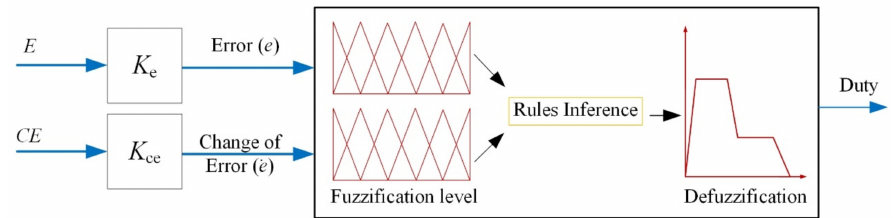
Figure 11. Normalized FLC